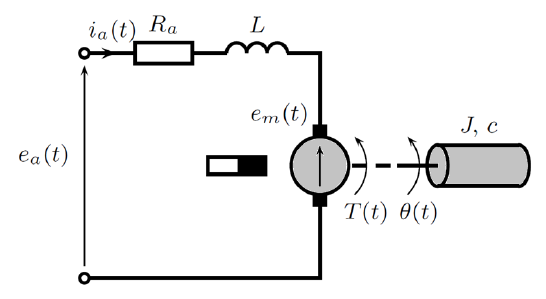
Figure 1. Diagram of the experimental setup.